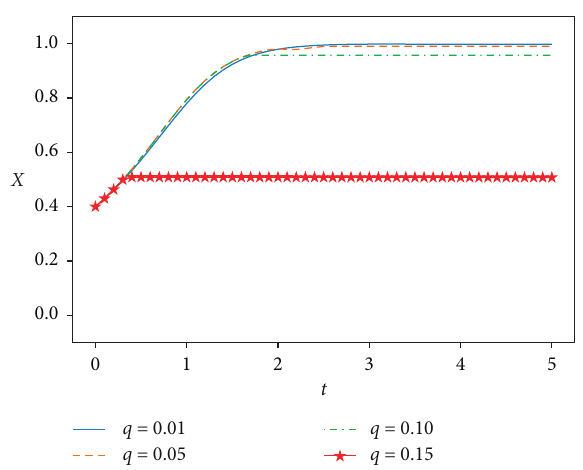
Figure 3: Cooperation rate x ∗ ( t ) with β ∗ ( t )